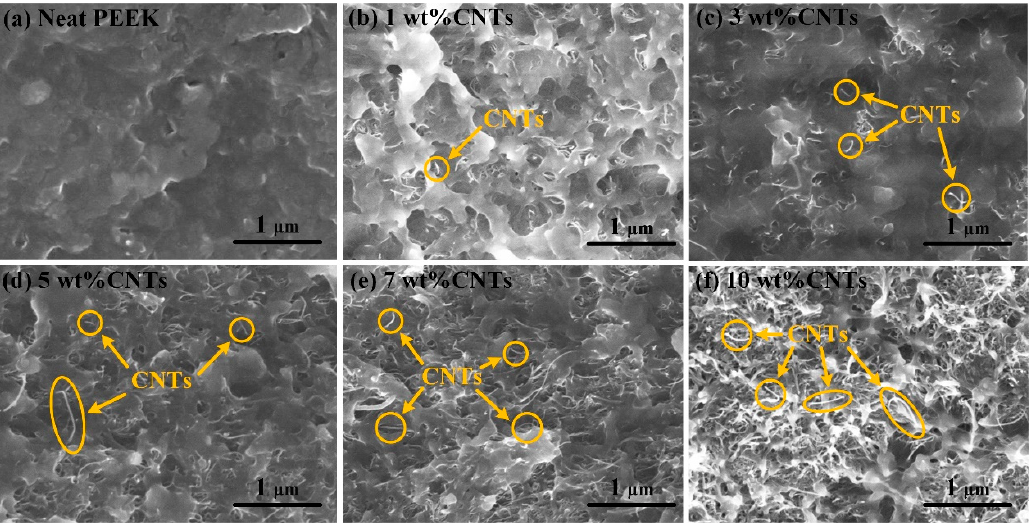
Figure 3. SEM images of PEEK/CNTs composite with different CNTs content. ( a ) Neat PEEK; ( b ) 1 wt% CNTs; ( c ) 3 wt% CNTs; ( d ) 5 wt% CNTs; ( e ) 7 wt% CNTs; ( f ) 10 wt% CNTs.